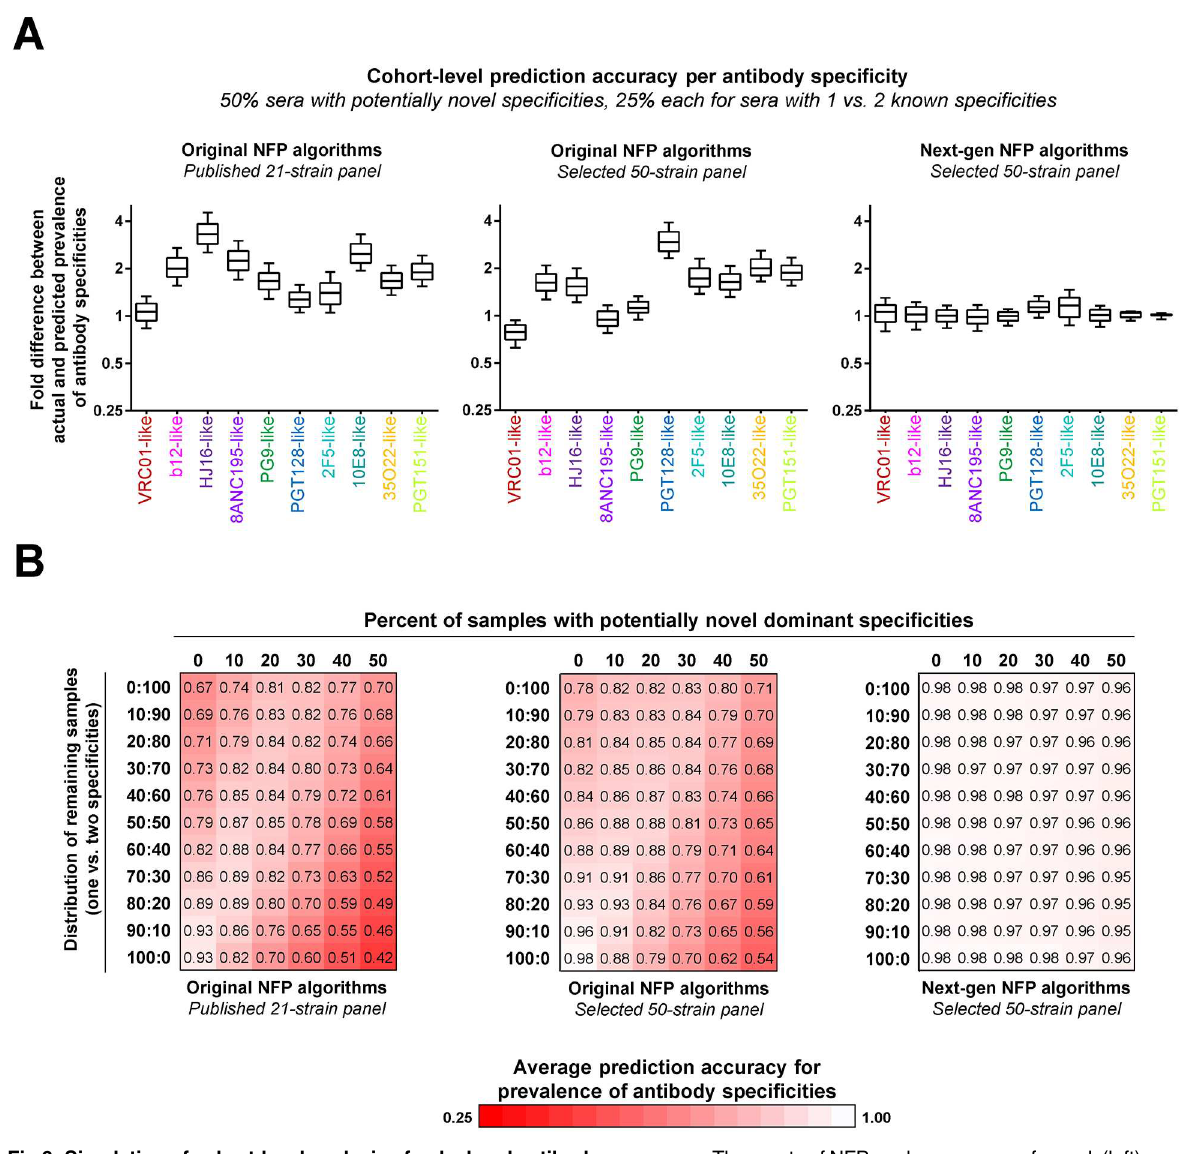
Fig 6. Simulation of cohort-level analysis of polyclonal antibody responses. Three sets of NFP analyseswere performed: (left) originalNFP algorithms with the published21-strain panel,(middle)originalNFP algorithms with a selected50-strain panel, and (right) next-generation NFP algorithmswith the selected50-strain panel. (A) Analysis for a simulatedsample with 50% sera with potentially novel specificities, and 25% each of sera with 1 or 2 dominant known specificities. For each antibody specificity from the reference set (coloredlabels), shown are fold differences betweenactual and predictedprevalence in 1,000 samples of 200 sera each. Boxes represent 25–75 percentiles of the data, with vertical bars corresponding to the 10–90 percentiles, and the medianshown as a horizontal line within each box. (B) Analysis for different distributionsof simulatedsera with known (rows) vs. potentially novel (columns) specificities. Each value shown is the averageof the medianfold differences for each of the ten specificitiesgiven the respective distributionof sera. Values are colored as a red-white